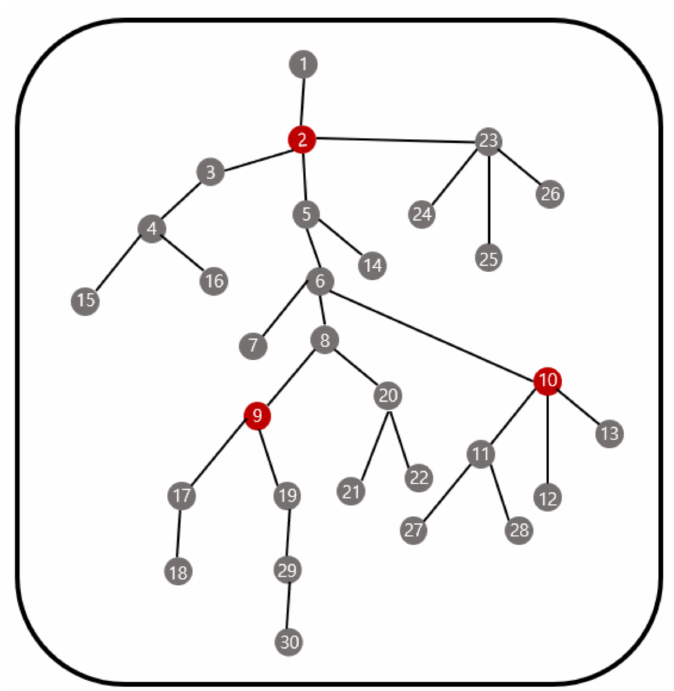
Figure 12. Gateway deployment by the genetic algorithm.